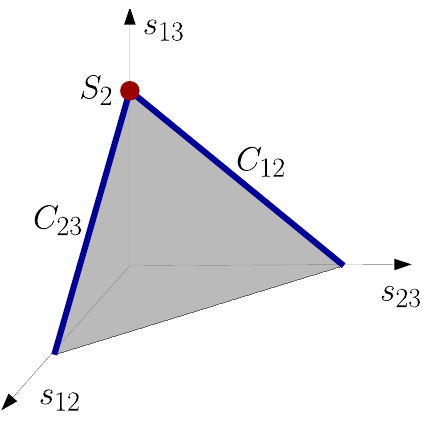
Figure 1 . The grey triangular surface Q 2 = s 12 + s 13 + s 23 represents the physical phase space. The fat blue lines labelled by C 12 and C 23 show the locations of collinear singularities, while the small red circle labelled by S 2 shows the location of the soft